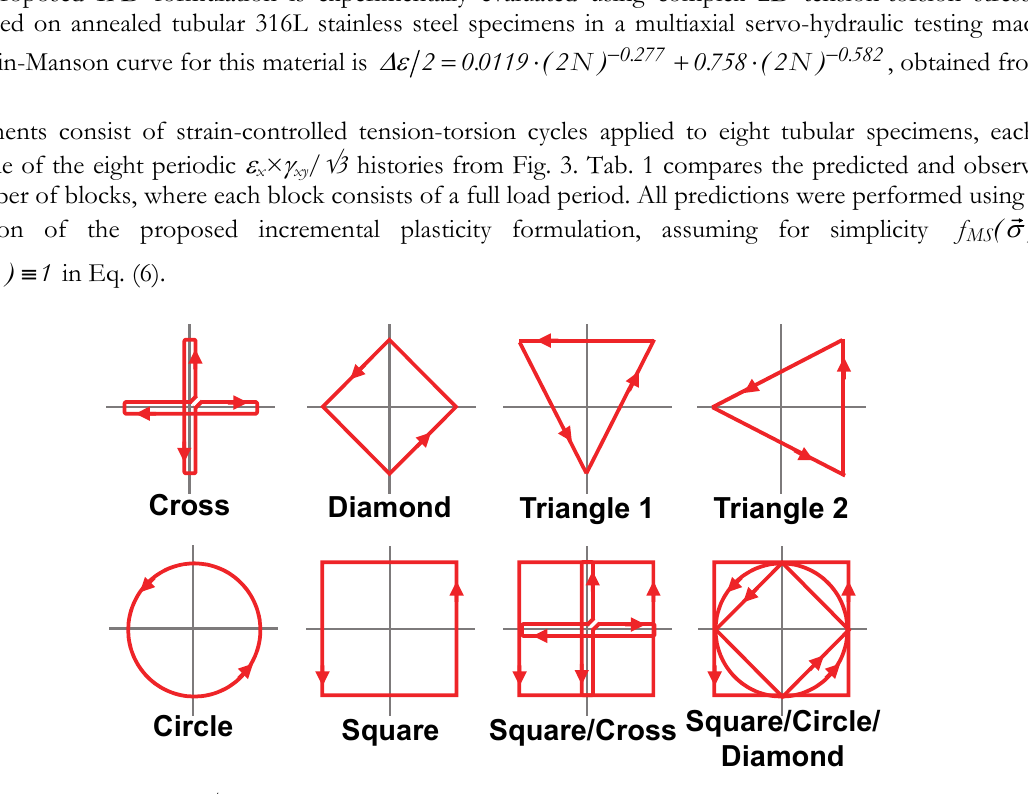
Figure 3: Applied periodic  x ×  xy /  3 strain paths on eight tension-torsion tubular specimens, all of them with normal and effective shear amplitudes 0.6%